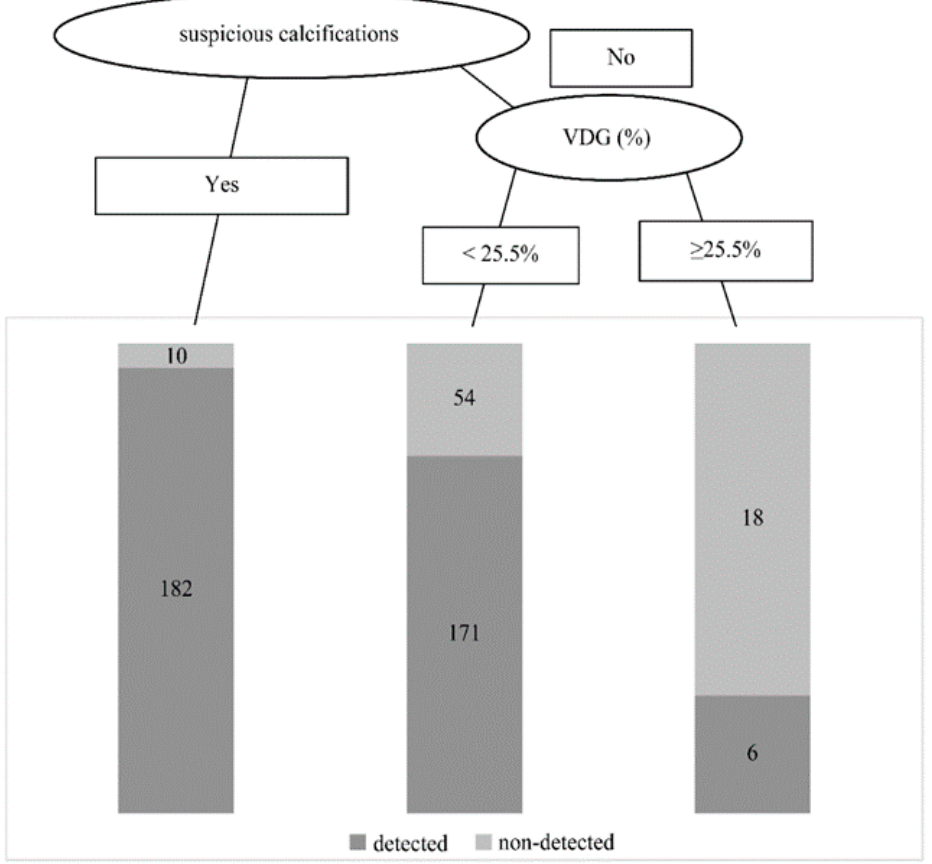
Figure 4. Risk factors for non-detected results and flow diagram leading to a non-detected result. VDG—Volpara Density Grade.